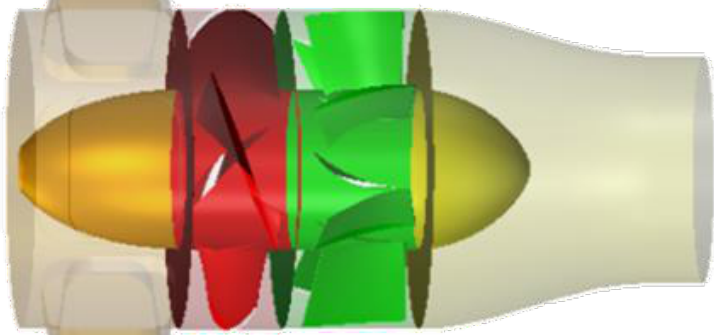
Figure 2. In the S1 scheme, the distance between the guide vane and the impeller is Δ h , Figure 1. 3D model of axial-flow pump. Figure 1. 3D model of axial-flow pump.